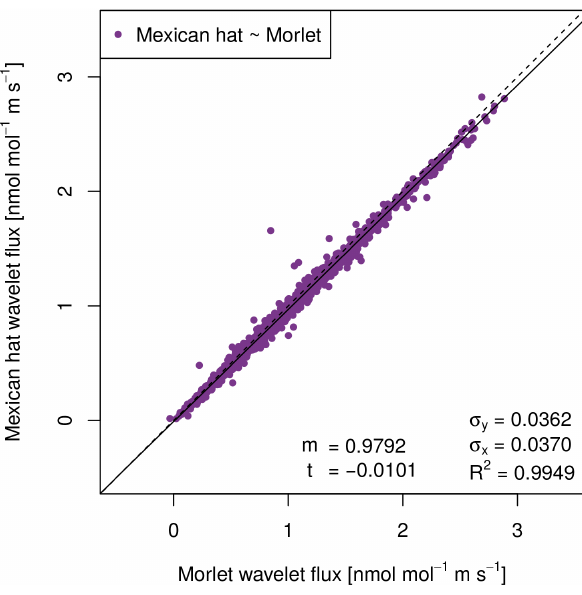
Figure 2. Scatterplot of Morlet against Mexican hat wavelet methane flux (right) for times with best steady-state conditions and well-developed turbulence. The dashed line follows the function f (x) = x and the solid one is the orthogonal regression